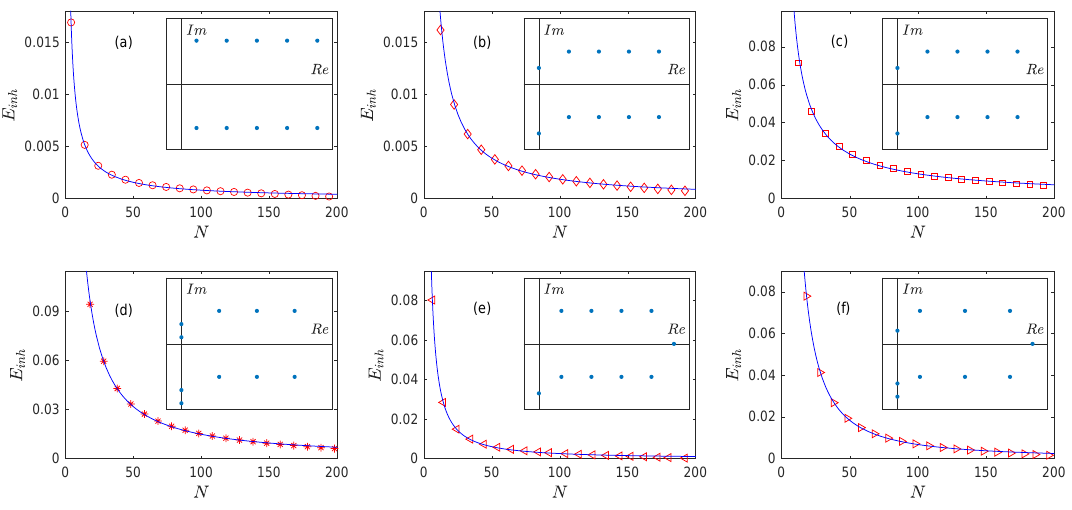
Figure 2: The values of E versus the system size N . The data can be inh = γ N β . Due to the fact β < 0, when the size of system fitted as E inh N → ∞ , the contribution of the inhomogeneous term tends to zero.